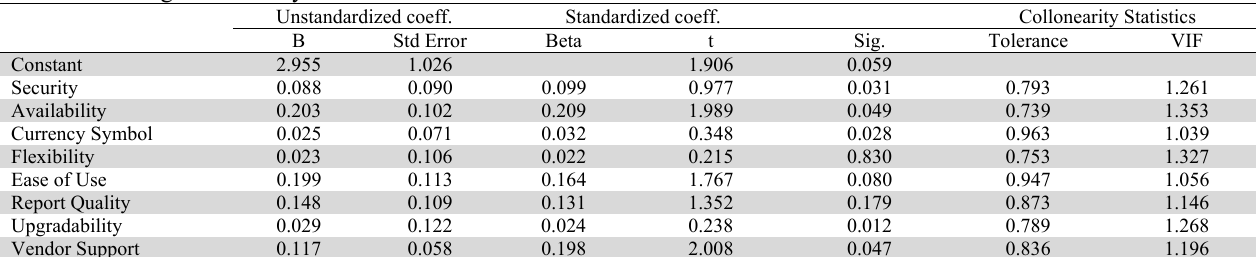
The results of regression analysis